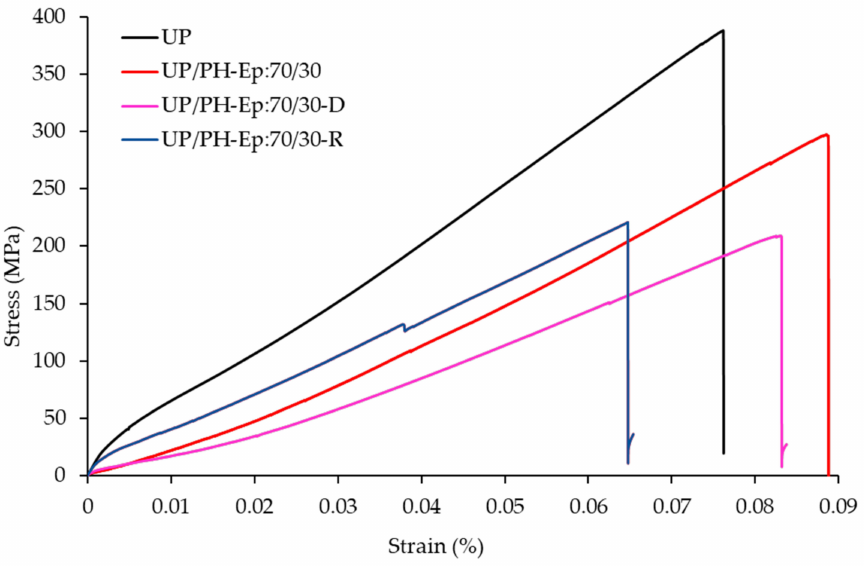
Figure 6. Stress vs. strain curves for GFRCs of UP and UP/PH-Ep:70/30 with FRs in tensile